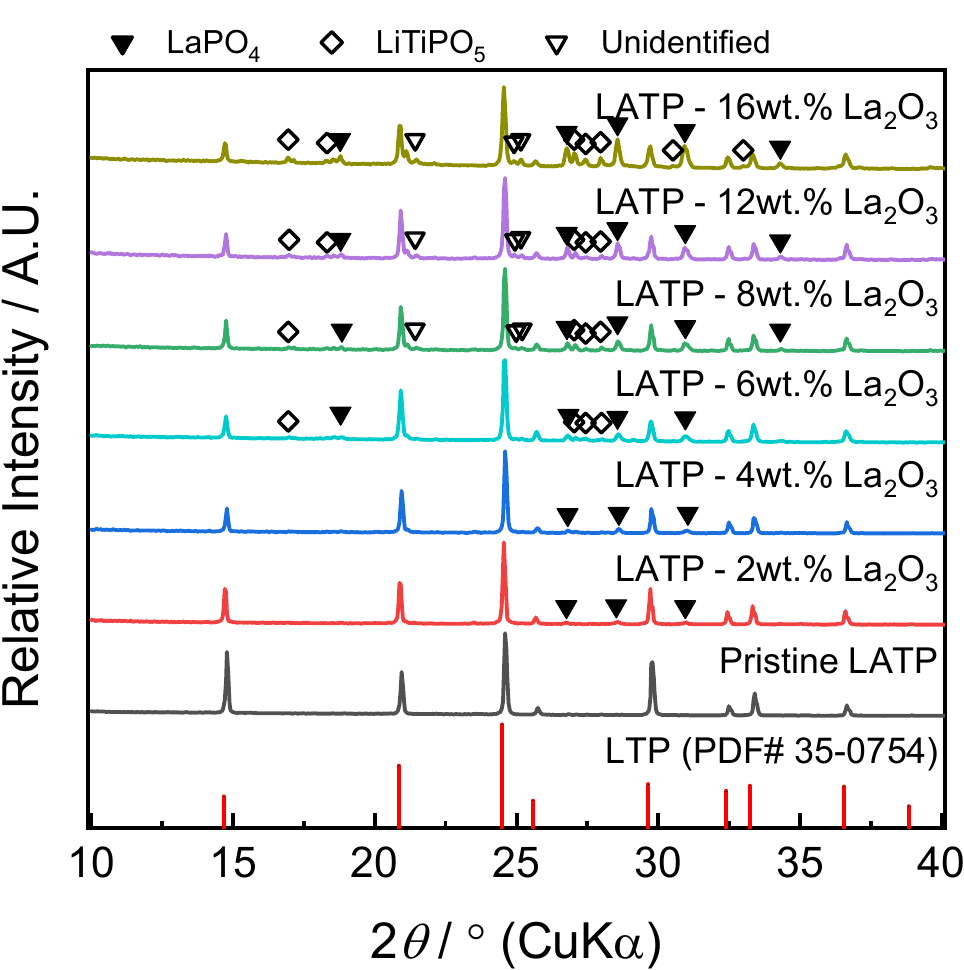
Figure 1. Powder XRD patterns of pristine LATP and LATP–La 2 O 3 composites. LaPO 4 , LiTiPO 5 and unidentified phases are labelled by solid inverted triangle, hollow diamond, and hollow inverted triangle, respectively.